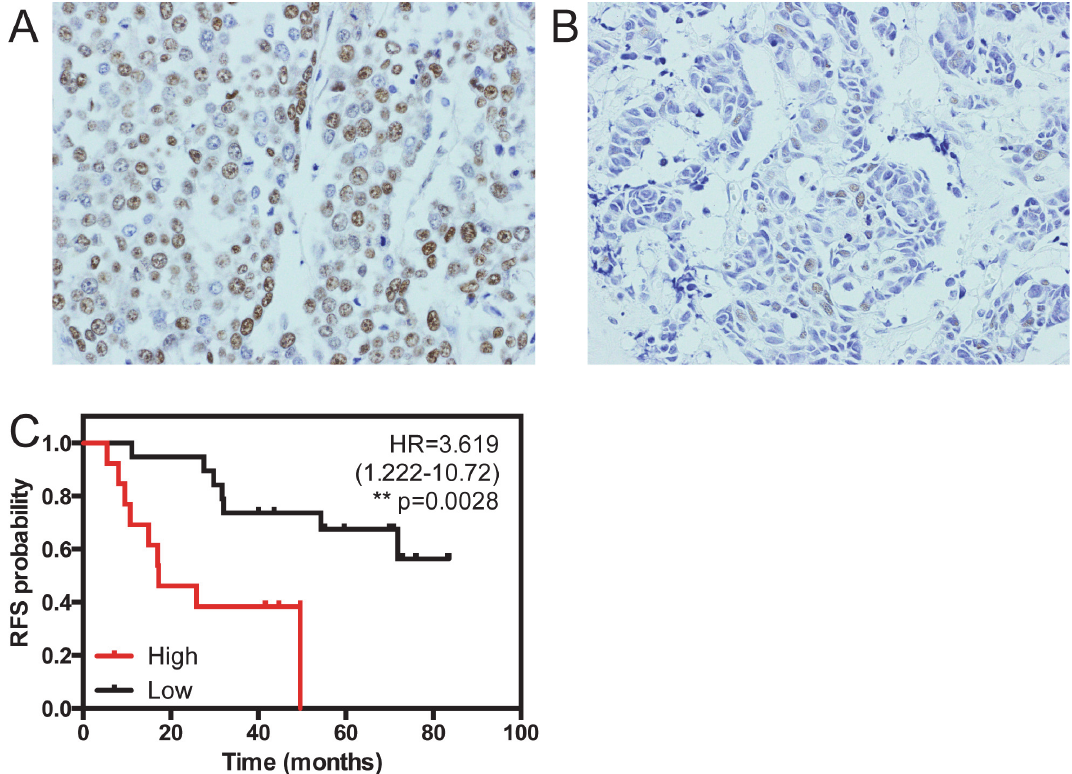
Fig 3. Overexpression of LSD1 is linked to poor outcome in triple negative breast cancer. Representative images of immunohistochemistry of LSD1 in 20 clinical samples are shown (A and B, LSD1 high and low, respectively). The Kaplan Meir curve compares the recurrence free survival of cancer with high or low level LSD1 protein products (C). Definition of LSD1 high is samples that have IHC scores above